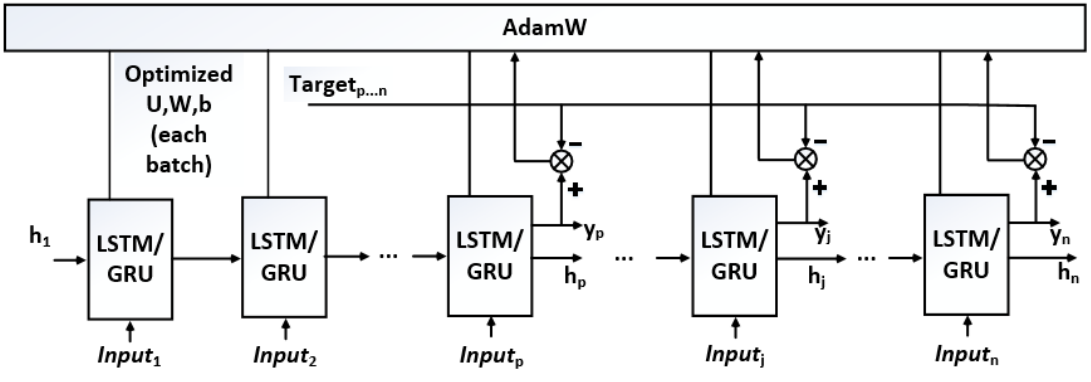
Figure 7. Flow chart of the training process. Table 1. 31 positions with nine different indexations of balls 1, 2, 3, and 4. Positions of Artefact